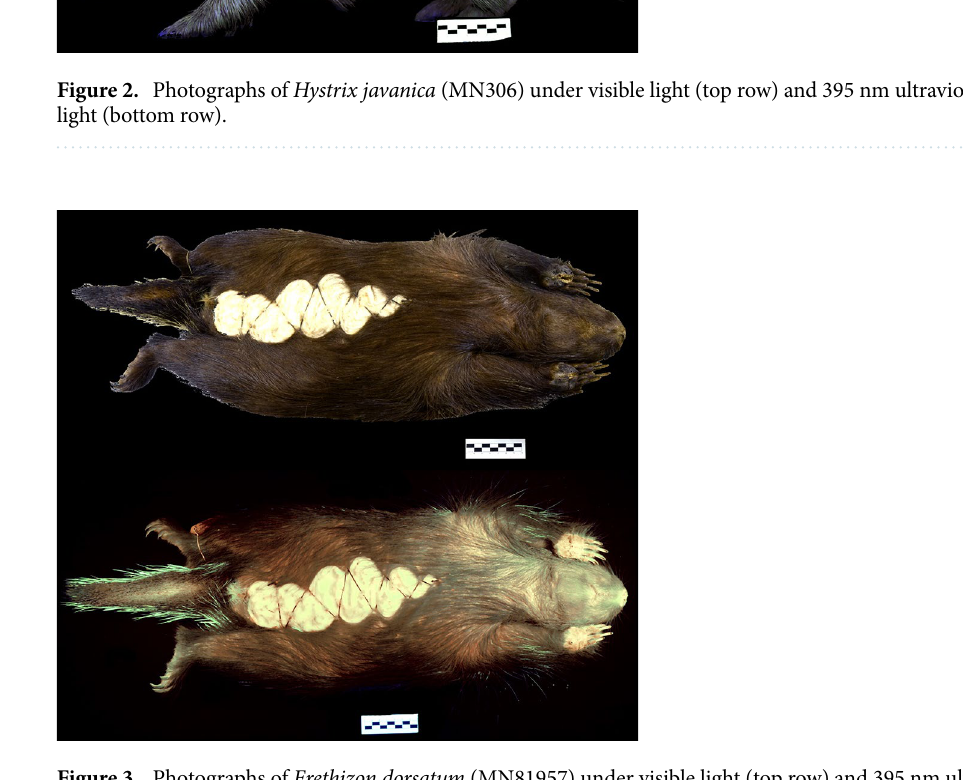
Figure 3. Photographs of Erethizon dorsatum (MN81957) under visible light (top row) and 395 nm ultraviolet (UV) light (bottom